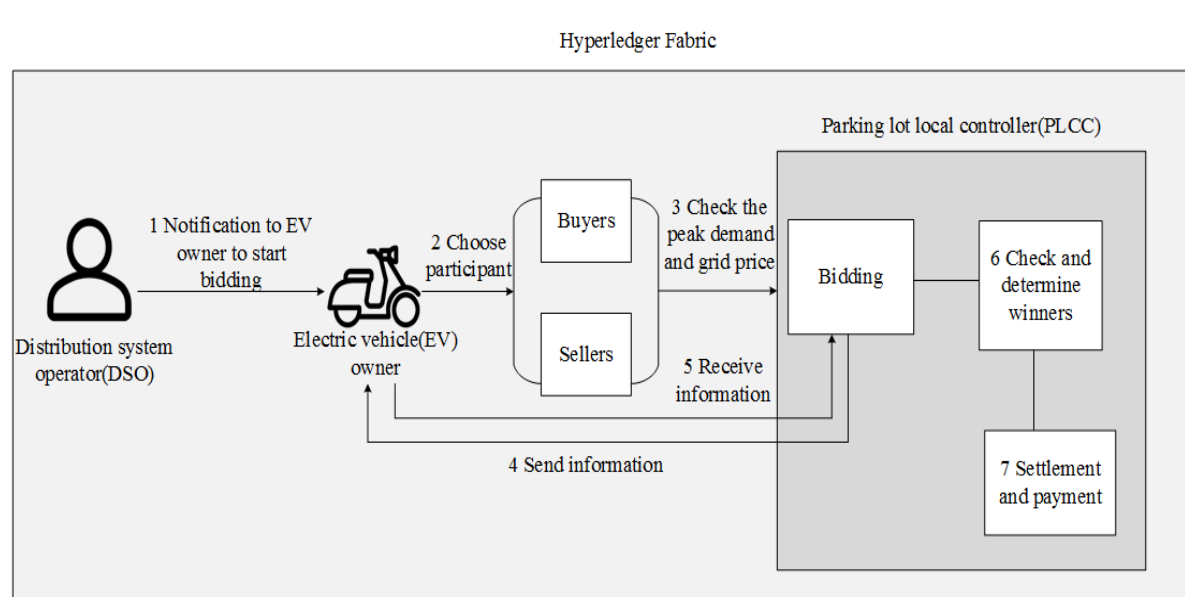
Figure 50. Reconstruction diagram of reference [84].